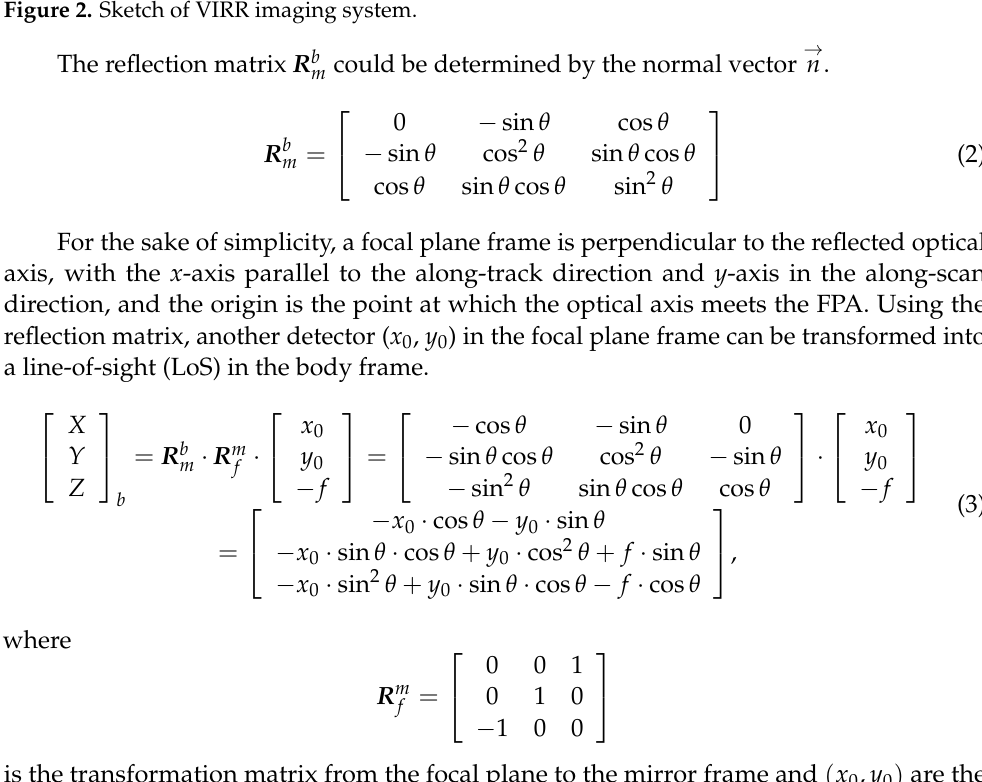
is the transformation matrix from the focal plane to the mirror frame and ( x 0 , y 0 ) are the positions of the detectors in the focal plane. For the reference band, x 0 = 0 and y 0 = 0. The (cid:2) (cid:3) T ray in the body frame can be expressed as . 0 f · sin θ − f · cos θ The detector from the optical axis, with inner orientation parameters x 0 , y 0 , f , captures (cid:2) (cid:3) T X b Y b Z b the point at scan angle θ , as shown in Equation (3). The differences in ephemeris and attitudes were ignored because of the short time intervals. To capture the same point, the optical axis should have different scan angles θ − ∆ θ and different positions − ∆ x in the flight direction. In this case, the LoS of the reference band